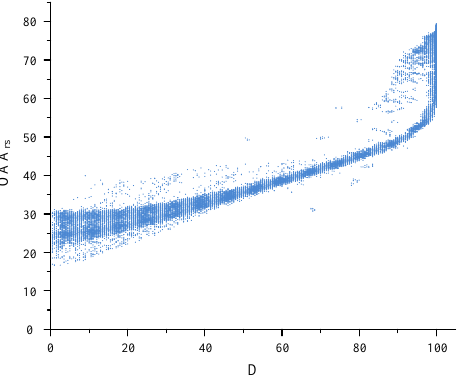
Figure 12. The relationship between the reachability indexes and the obstacle avoidance ability indexes of all reachability